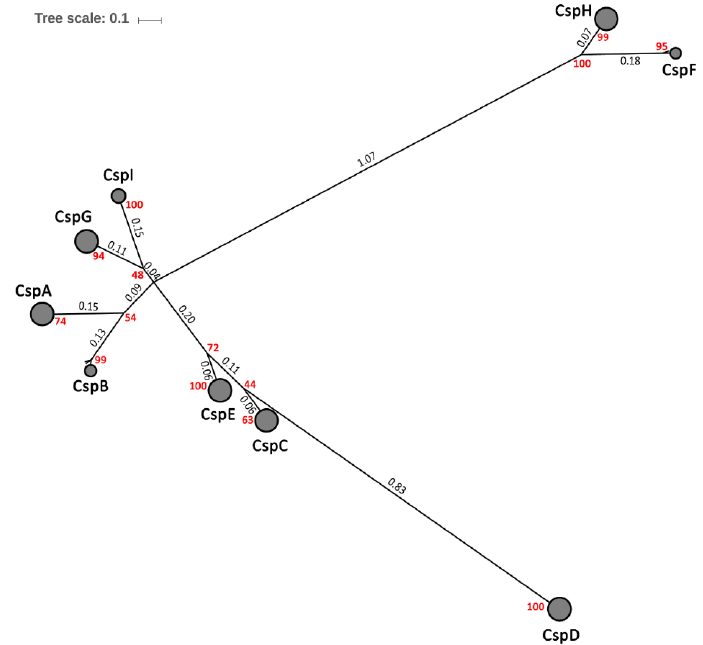
Figure 2. Phylogenetic tree for Csps in Escherichia coli . A phylogenetic tree composed on 1013 Csps in 135 E. coli strains. Monophyletic nodes have been collapsed and are represented by a circle. The number of Csps in a collapsed node is indicated by the circle radius. Black numbers indicate the evolutionary distances between the main nodes, and red numbers indicate the bootstrap values.